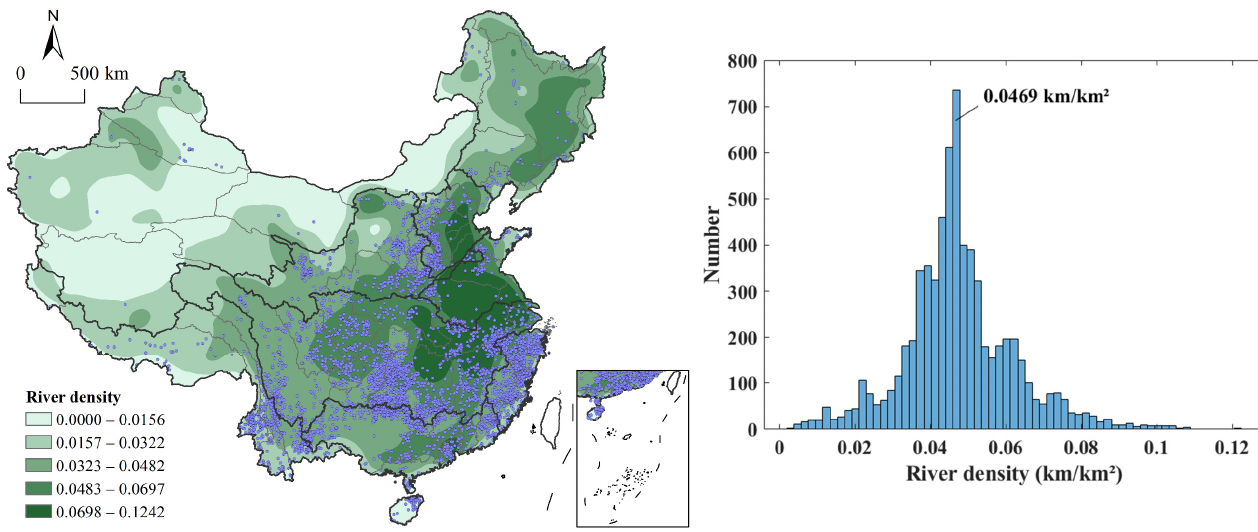
Figure 6. Relationships between traditional villages and river density in China.